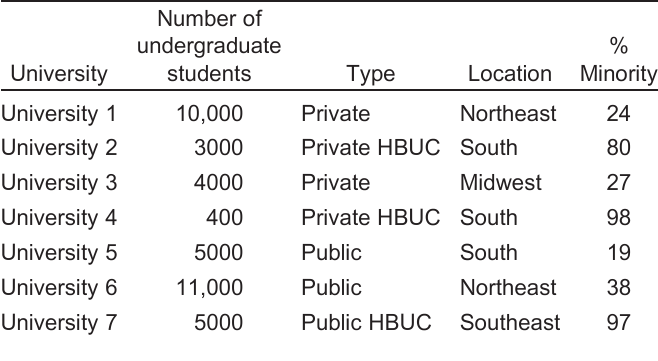
Table 1. Universities by